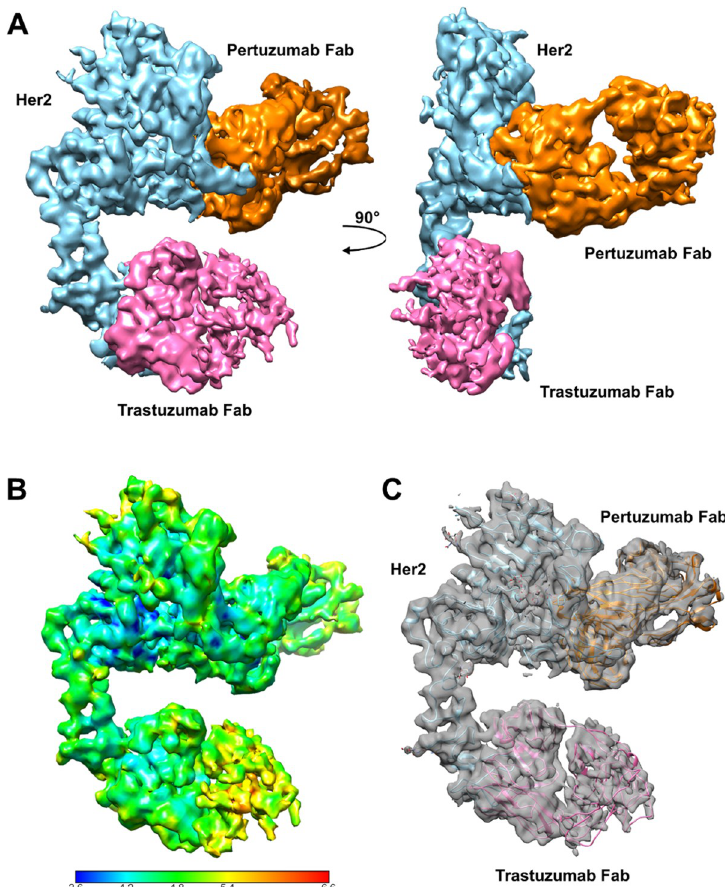
Fig 3. Cryo-EM map of HER2-trastuzumab-pertuzumab. A. Cryo-EM map showing the three components of the ternary complex: HER2 (sky blue), trastuzumab Fab (pink), and pertuzumab Fab (orange). B. Local resolution analysis of the final construction calculated using ResMap. C. Final construction (grey surface) with HER2 (sky blue), trastuzumab Fab (pink), and pertuzumab Fab (orange) fitted in the map. Glycans on HER2 are shown as sticks.